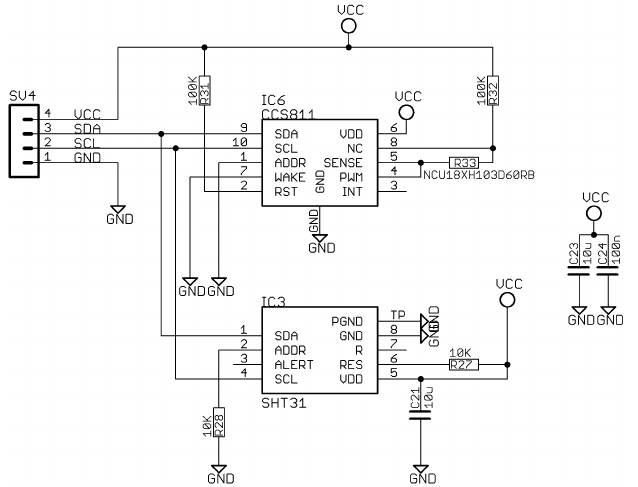
Figure A5. Electronic circuit of the air quality sensors (CCS811 of BioSense company) and temperature-humidity (SHT31 of Sensirion company). Communication with the main processor occurs via I2C Bus.